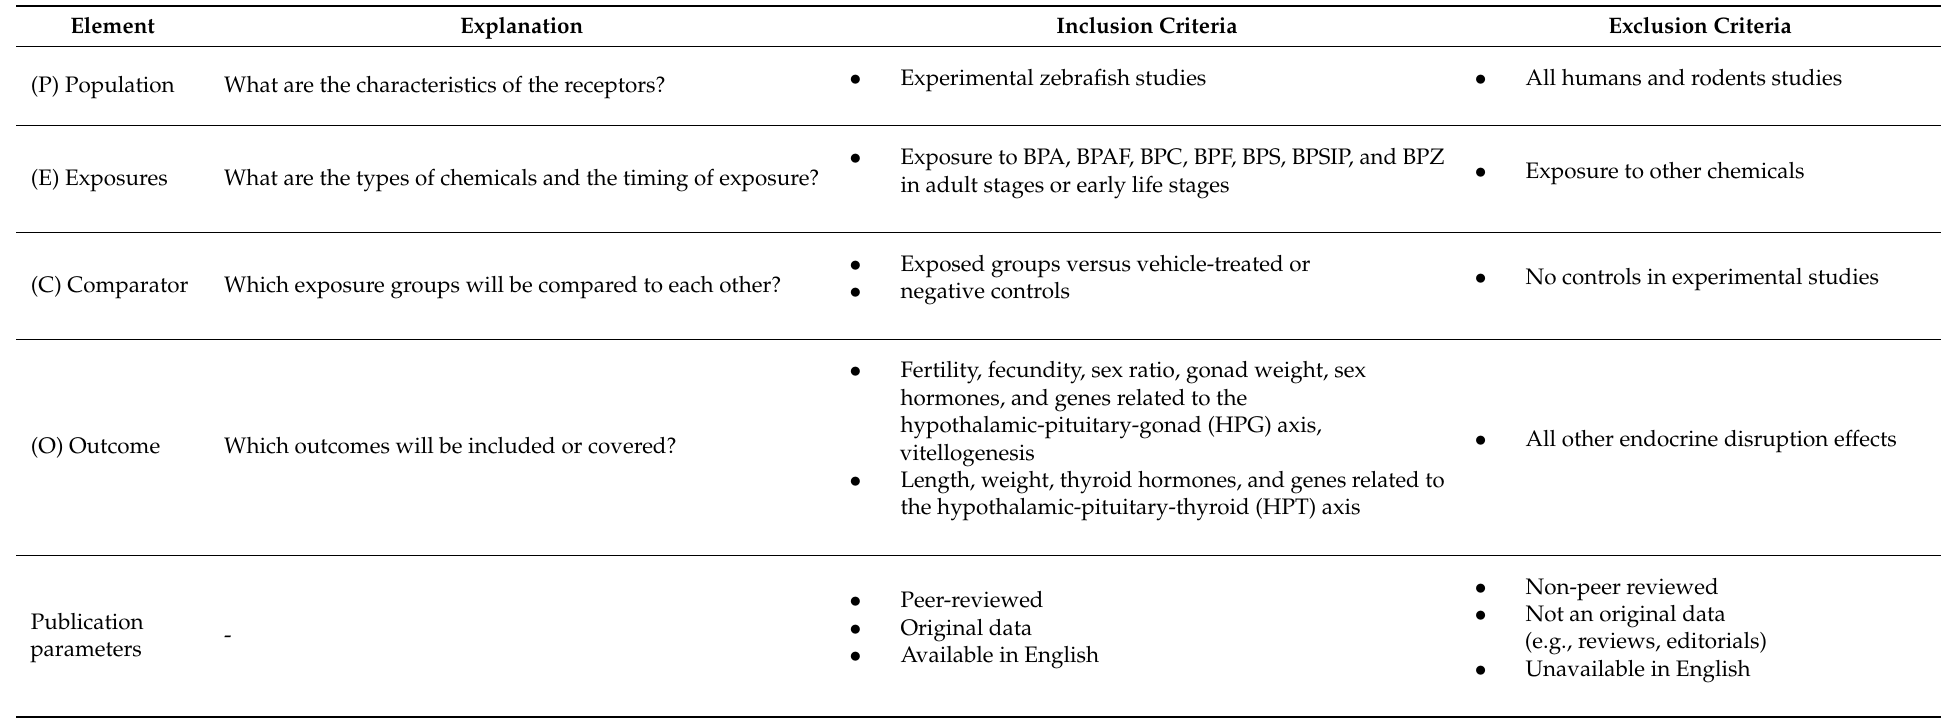
Table 2. Elements of a population-based comparator-outcome (PECO) statement in the present